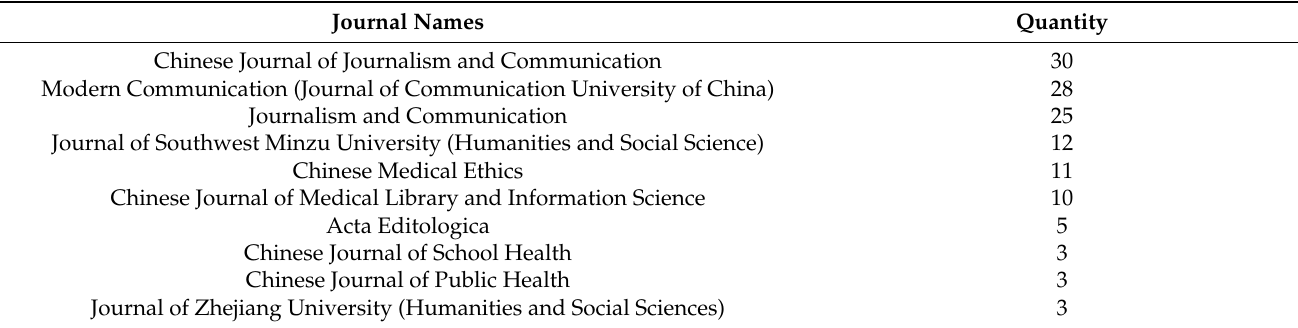
Table 1. Top 10 journals ranked by the number of publications in the field of